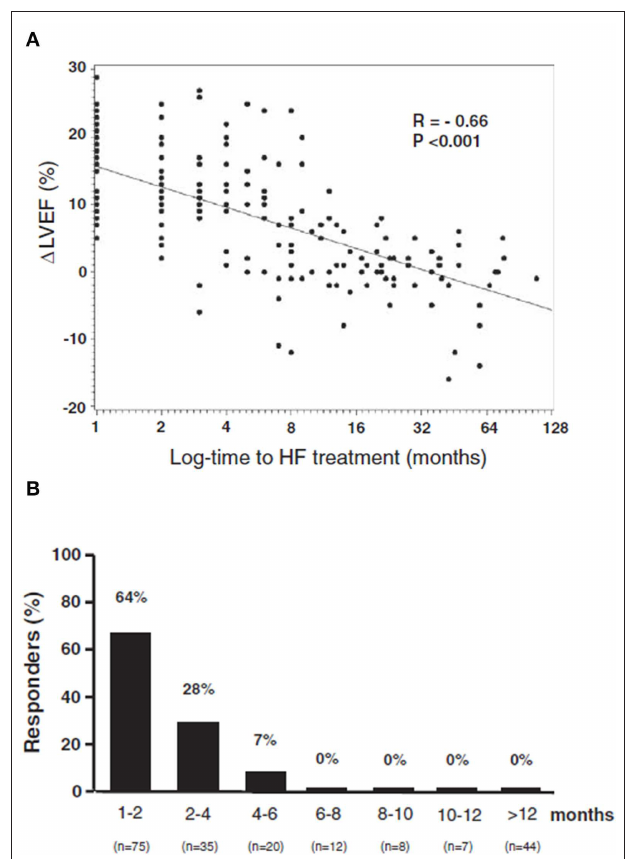
FIGURE 4 | (A) Percentage of patients who recovered (Responders), according to the time elapsed from anthracycline administration and the start of heart failure therapy. (B) Relationship between maximal LVEF during the follow-up period and log time elapsed from chemotherapy and the start of treatment [time-to-heart failure (HF) treatment]. From Cardinale et al.